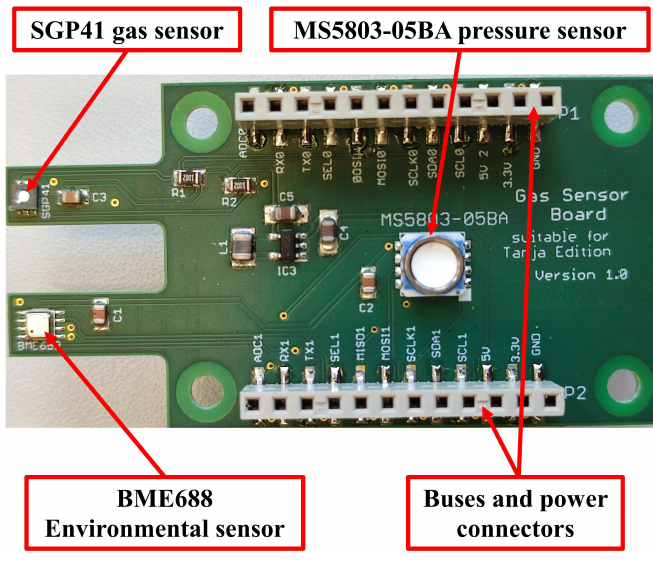
Figure 2. Sensing layer.